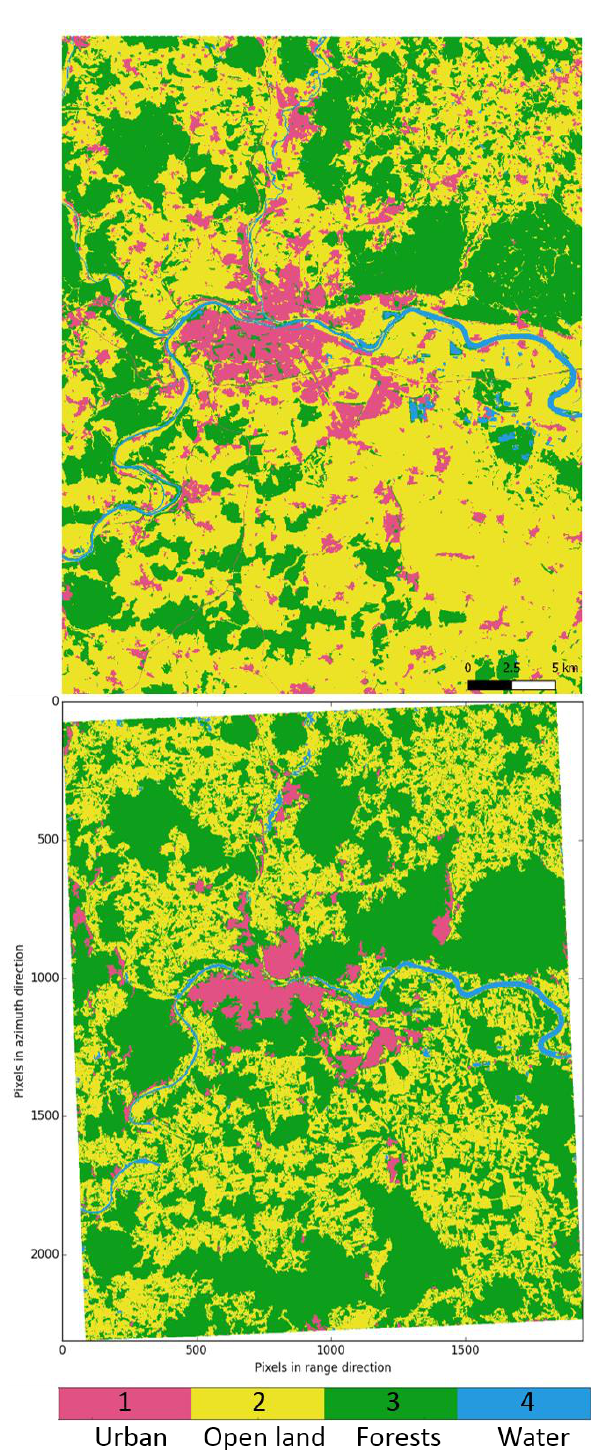
Figure 6. Top: LBM2012-DE colour coded with 4 land cover classes. Bottom: SAR-backscatter based classifier results with the same four classes and colour coding.